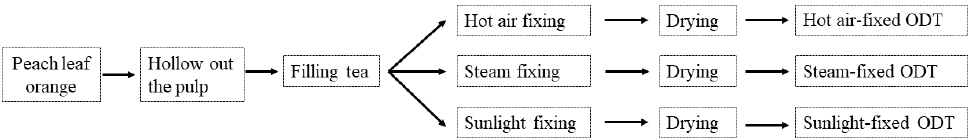
Figure 6. Flow diagram for processing different types of orange dark tea.